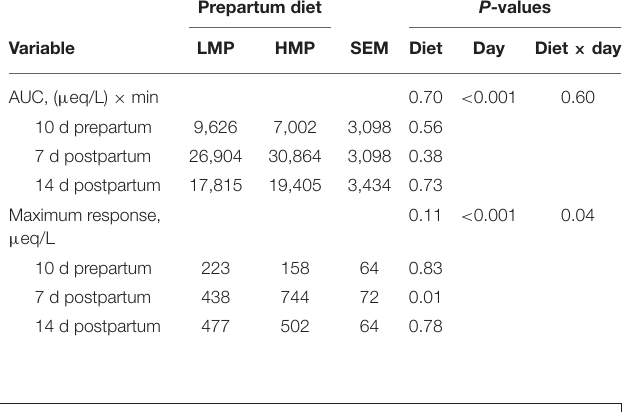
TABLE 6 | Area under the curve (AUC) for NEFA and maximal NEFA response in plasma to epinephrine administration in dairy cows fed low (L) or high (H) amounts of metabolizable protein (MP) prepartum.